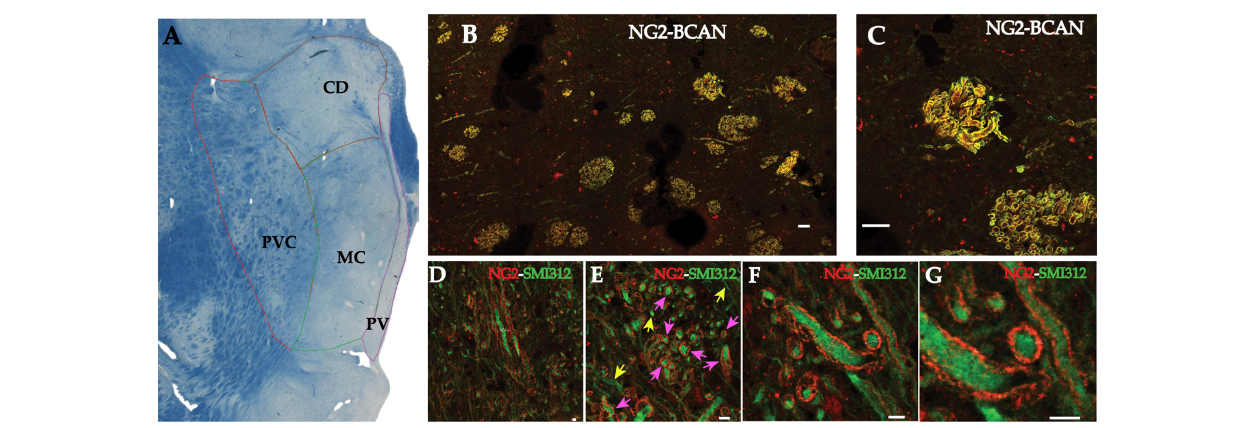
FIGURE 1 | NG2 and BCAN form coats surrounding axons in the human MD thalamus. Photomicrograph of a luxol blue stained section depicting the subregions of the human mediodorsal nucleus sampled for quantification of axonal coats (A) . Myelinated fiber bundles were sampled from the parvocellular (PVC), the magnocellular (MC), caudodorsalis (CD) regions of the MD. (B) Low magnification (10 × ) confocal image of NG2 labeling (red) and BCAN labeling (green) in the mediodorsal nucleus of the human thalamus. Labeling for both CSPGs was observed in structures resembling myelinated fiber bundles. Higher magnification images (C) revealed that these CSPGs labeled tube-like structures apparently surrounding openings that were consistent with the diameters of single axons. Scale bar equals 30 µ m. Confocal micrographs of dual immunofluorescence labeling revealed that these CSPG structures resembling axonal coats, labeled with NG2 (red), surrounded SMI-312 immunoreactive axons (green). (D) Low magnification (10 × objective) image showing NG2 axonal coats around SMI-312 axons in transverse and cross-section slices of the axons. (E) An intermediate magnification image depicting an example of cross-sectional SMI-312 axons surrounded by NG2 coats. Pink arrows indicate axons surrounded by NG2 coats, yellow arrows indicate axons without NG2 coats. (F) High-resolution imaging allowed for measurements of the diameter of these axons (3.95 and 3.99 µ m) as well as the thickness of the NG2 axonal coats [892 and 856 nanometers; (G) ]. Scale bars equal 4 µ m for D–G